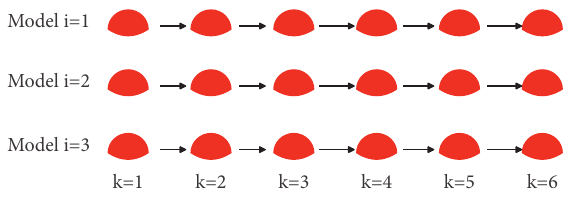
Figure 6: SMM algorithm structure